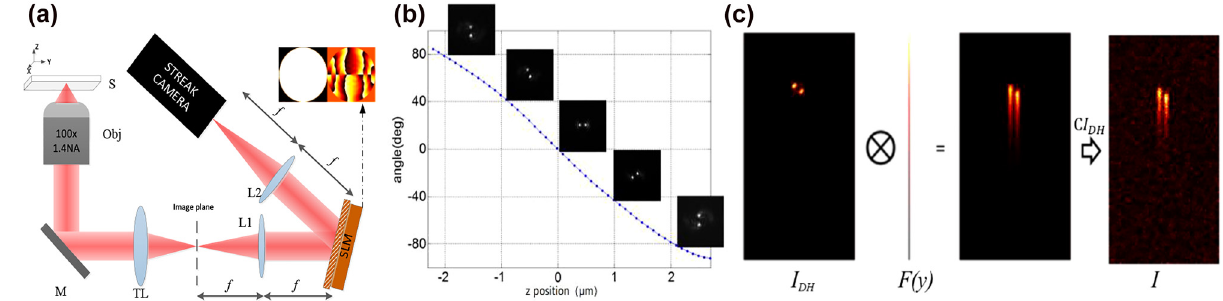
Figure 1: Principle of 4D-tracking method. (a) Collection light path of the 4D-tracking setup: the sample fluorescence of (S) is collected and imaged via an objective (Obj) and a tube lens (TL), and then modulated with a 4f relay system, consisting of two focal-length-matched achromatic lenses (L1 and L2) and a phase pattern implemented using an SLM, to generate the DH-PSF. (b) Calibration curve illustrating the relationship between the rotation angle of the two lobes of the DH-PSF and the z -axis position. (c) Schematic illustration of the convolution of the DH-PSF and a monoexponential function to generate the image acquired by the streak